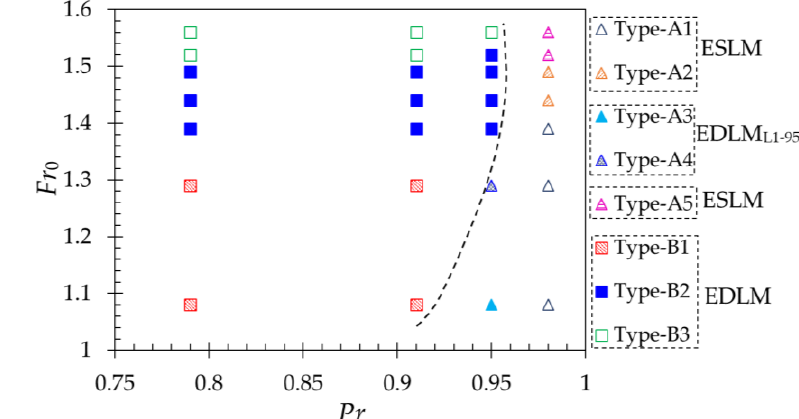
Figure 5. Classification of flow structure for di ff erent forest models and hydraulic conditions. Where the horizontal axis represents porosity ( Pr ) of L1 (Submerged Layer) and the vertical axis represents initial Froude number ( Fr 0 ); the dotted line represents the separation between Type A and Type B jumps.